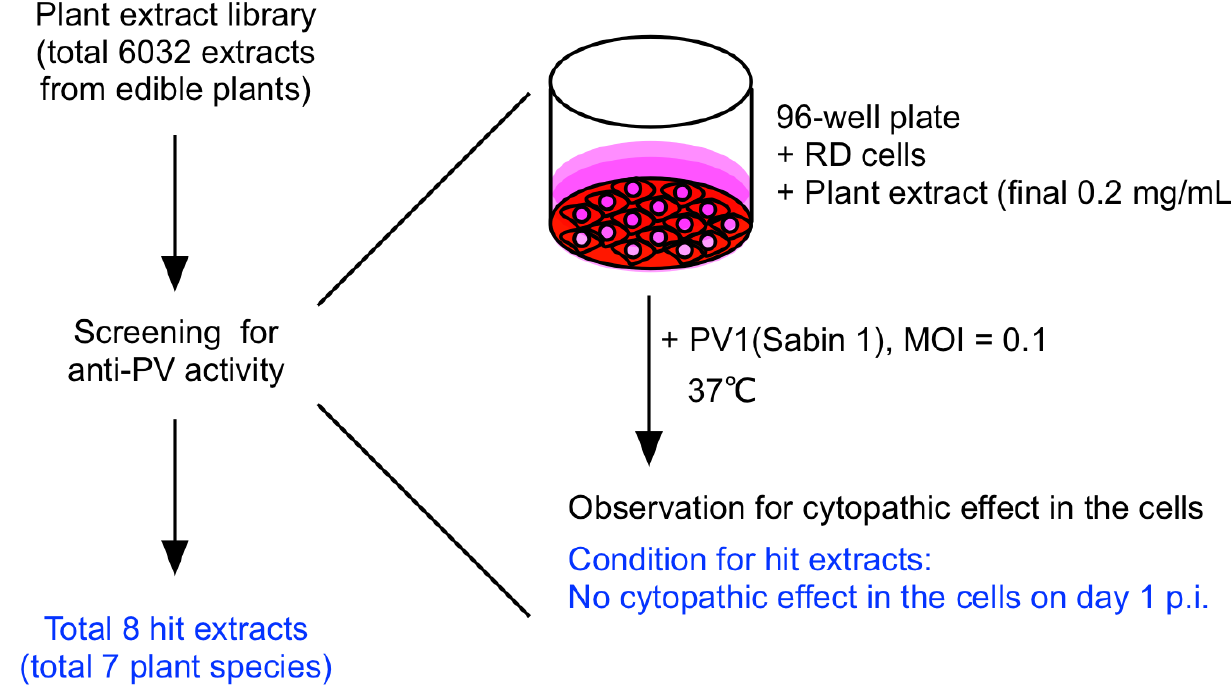
Figure 1. Summary of the screening of anti-PV compound from edible plant extract library.